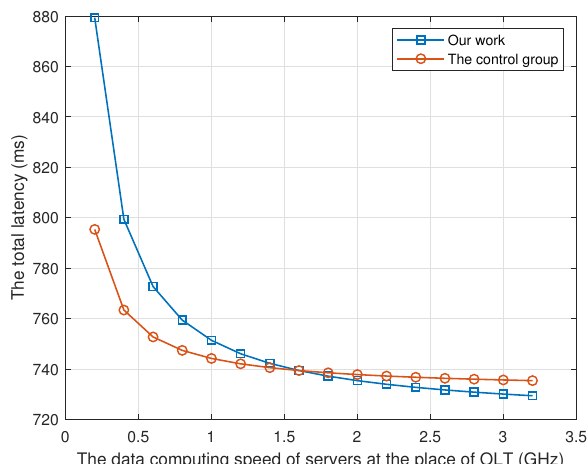
Figure 6. The total latency with MEC-2 offloading.